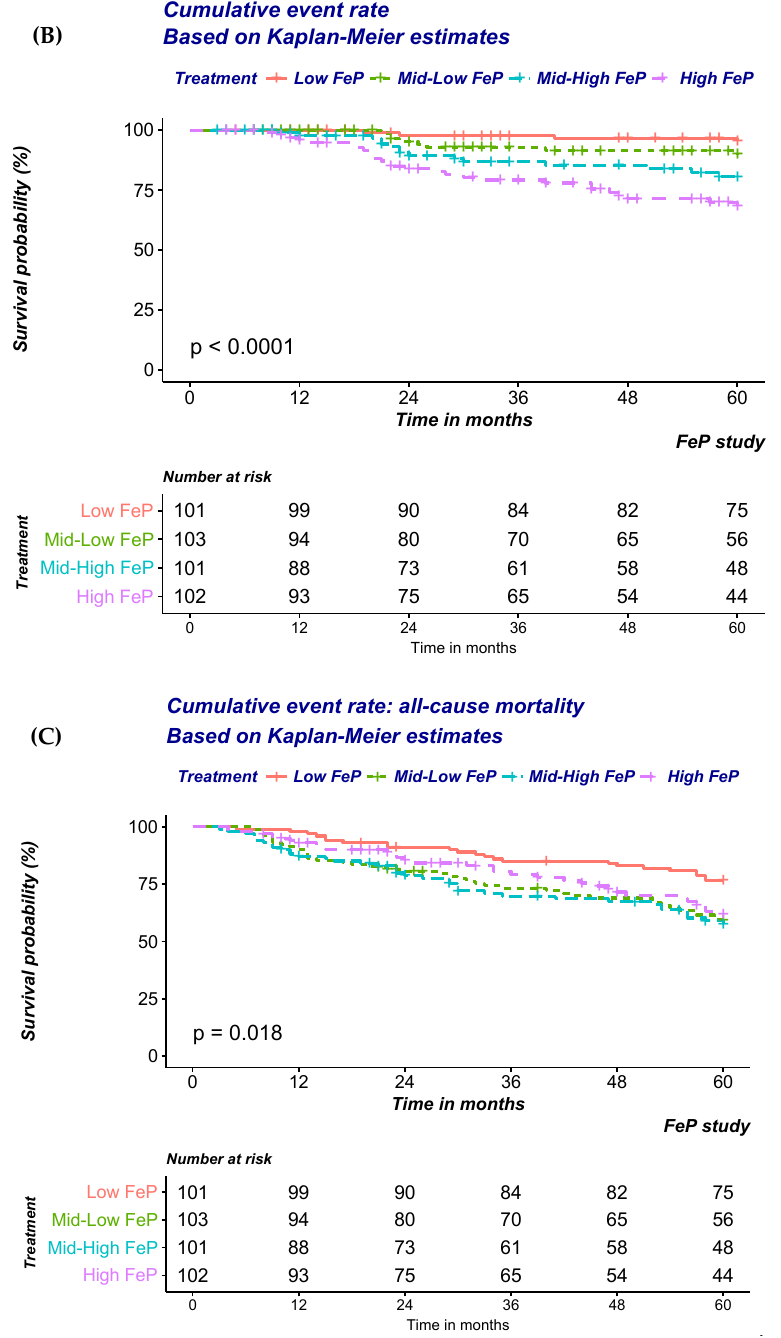
Figure 2. Overall likelihood of experiencing ( A ) the composite end point, ( B ) progression to ESRD, ( C ) all-cause mortality, according to quartile of Fractional Excretion of Phosphate (FeP) based on the Kaplan-Meier estimates. Table 4. time to event according to quartiles of Fractional Excretion of Phosphate (FeP). ( A ) time to the composite endpoint of all-cause mortality or progression to ESRD; ( B ) time to the progression to ESRD; ( C ) time to all-cause mortality. Analysis for each endpoint are presented unadjusted, adjusted for the case-mix (age, CVD, Hypertension, Diabetes, Systolic and diastolic blood pressure, renal